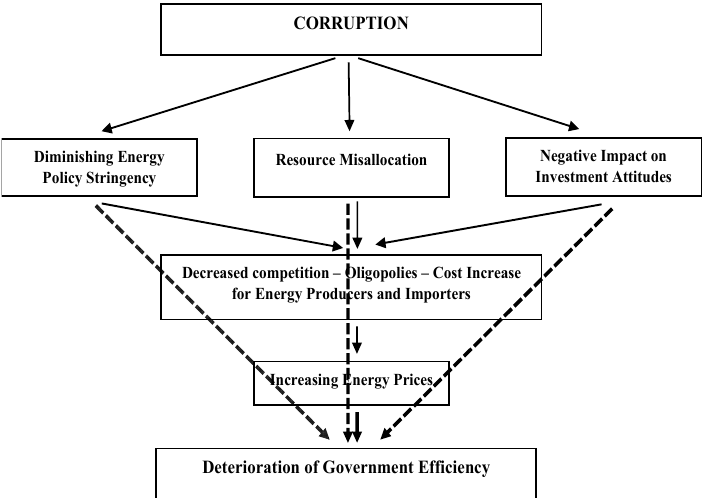
Figure 5. The indirect impact of corruption on energy prices and government efficiency.